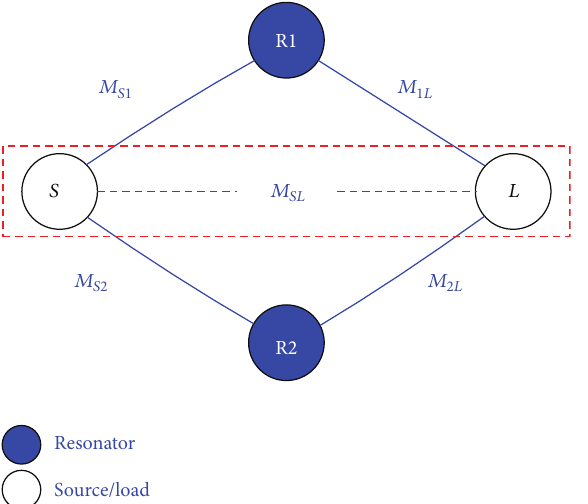
Figure 1: Coupling scheme of proposed dual-mode filter.